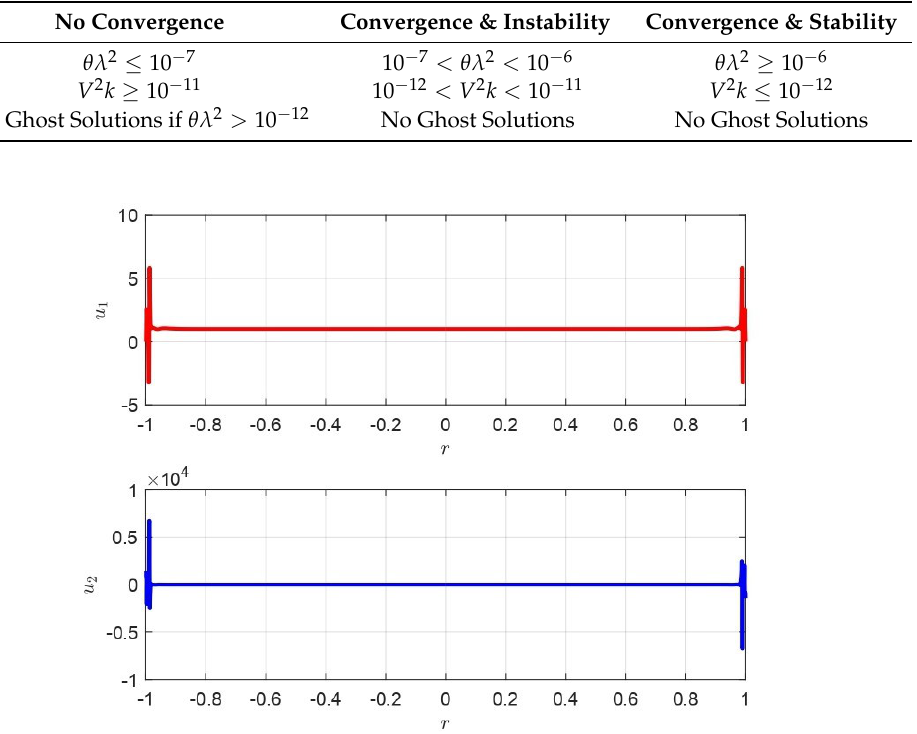
Table 1. Convergence and stability areas.